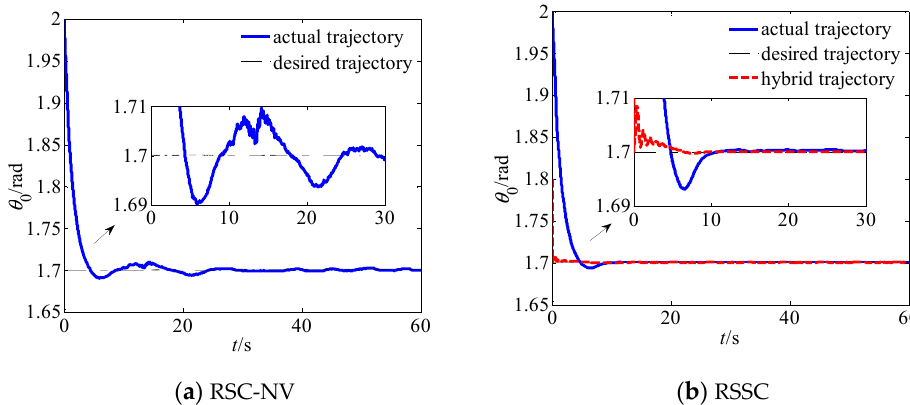
Figure 2. Trajectory tracking curve of the system base attitude.